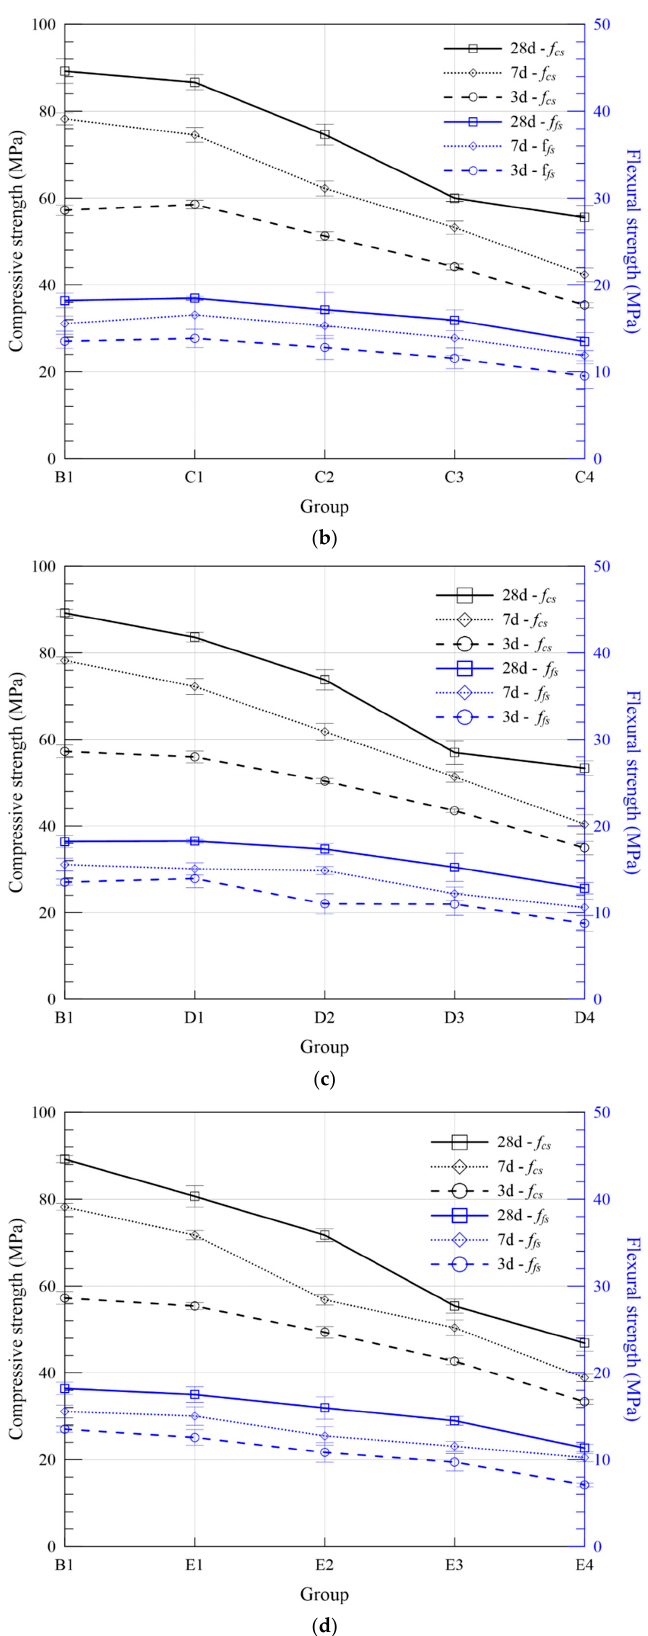
Figure 11. Strength of hardened MOC pastes with FA and ASR ( a ) Series B, ( b ) Series C, ( c ) Series D and ( d ) Series E.